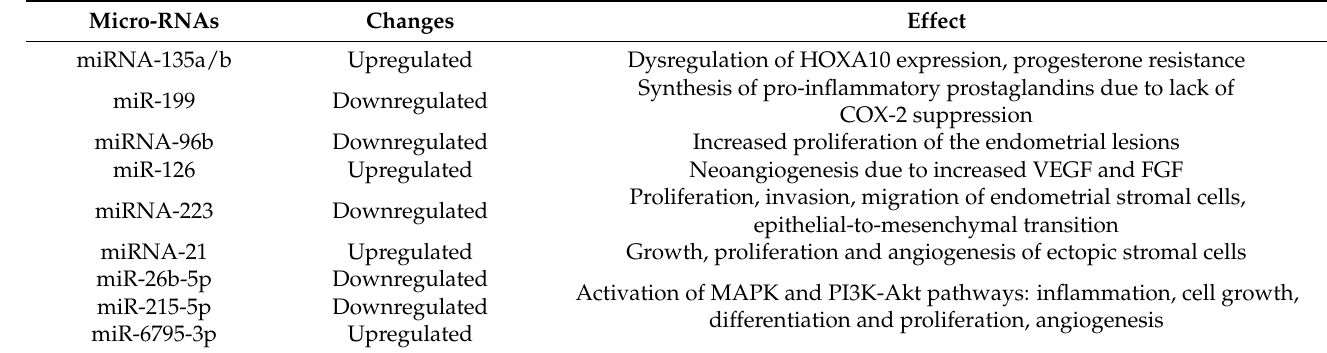
Table 1. Micro-RNAs and their